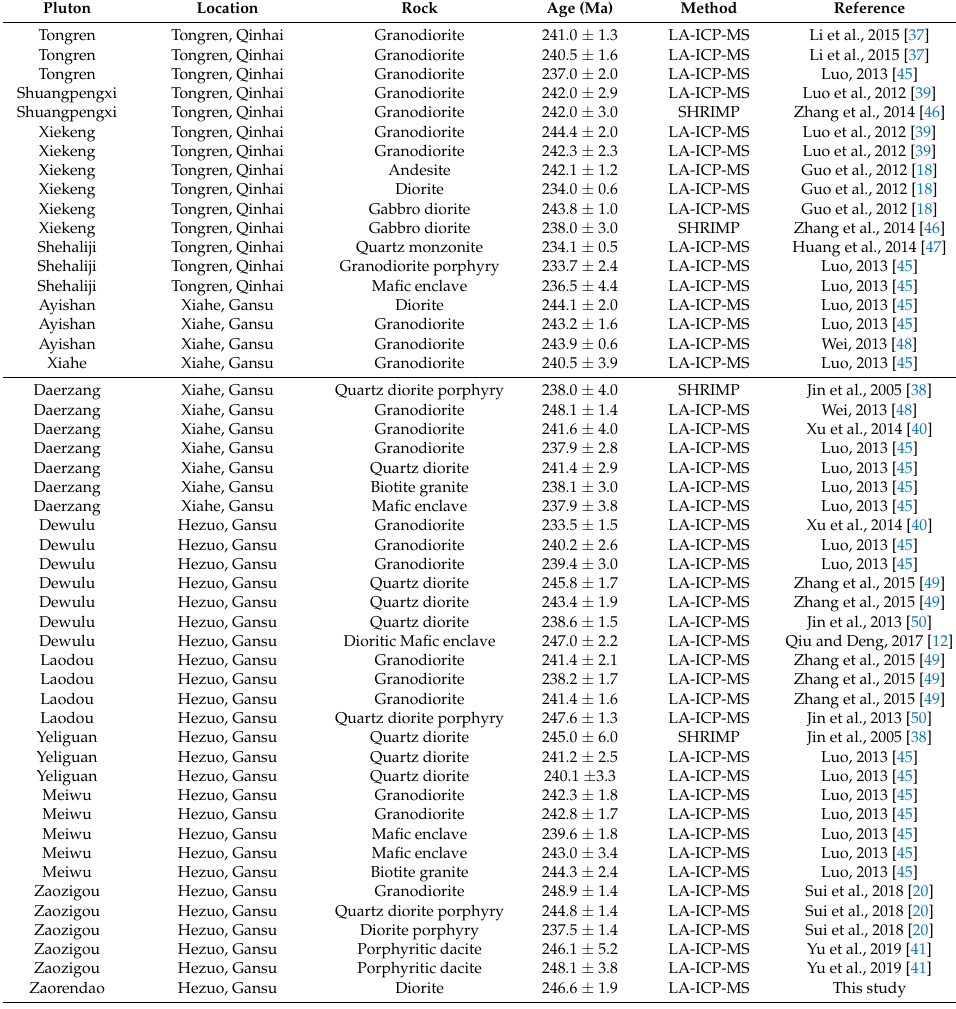
Table 1. Compilation of previously published zircon U–Pb ages of the Triassic magmatism in the Tongren-Xiahe-Hezuo polymetallic district.